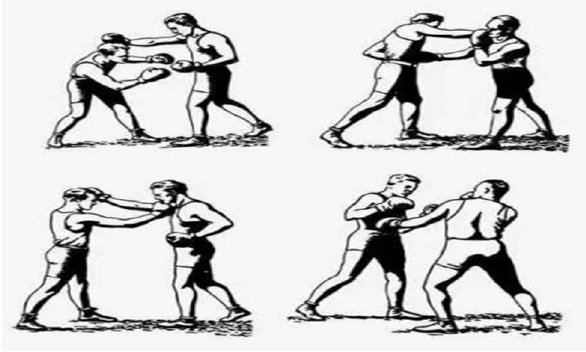
Figure 2: Comparison of tracking results of two di ff erent